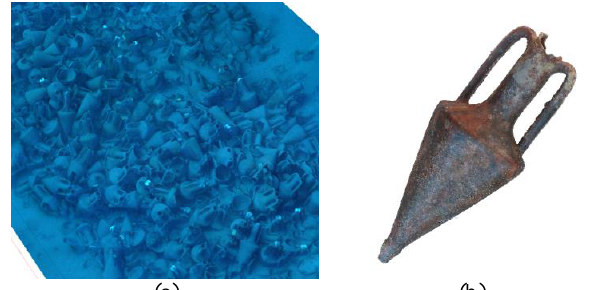
Figure 4. Mazotos shipwreck (a) close up of the textured 3D model and (b) textured 3D model of an Chian amphorae